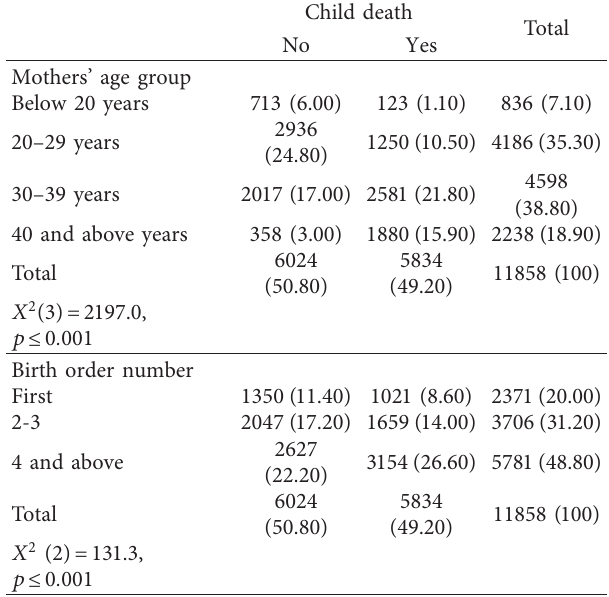
Table 11: Mothers’ age group and birth order number on child